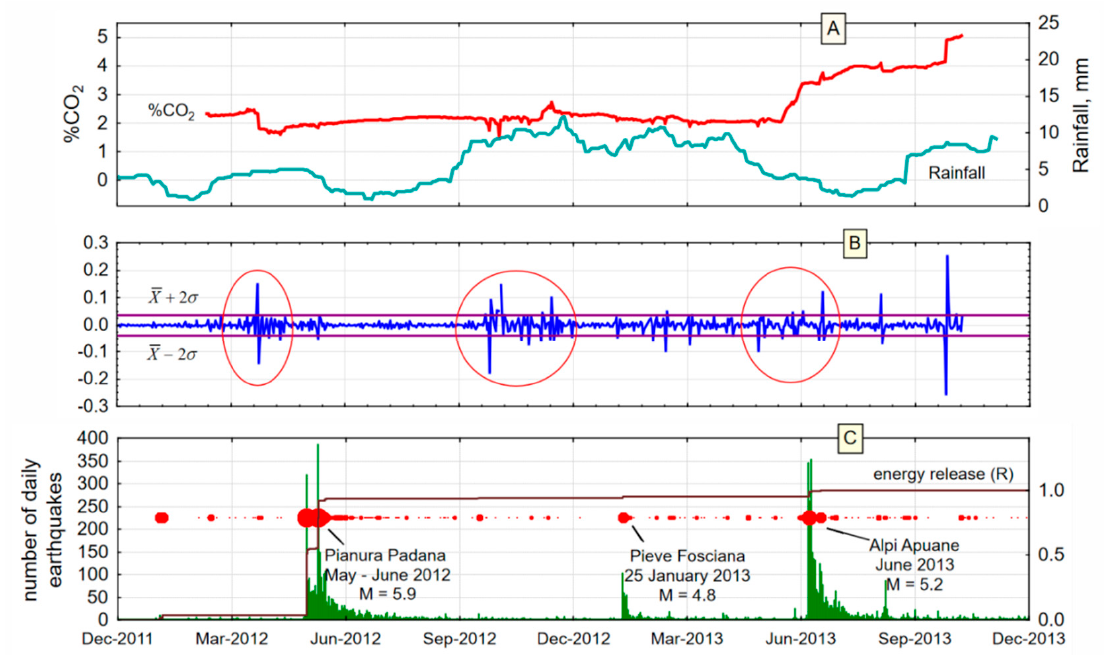
Figure 2. Time series for the Gallicano thermomineral spring (after [29]. ( A ) Aqueous %CO 2 and three-month rain moving average signals (rainfall data from https://www.sir.toscana.it/) during the February 2012 to October 2013 period; ( B ) irregular component of %CO 2 signal (processed with Census I method [32]). Anomalies are encircled by red ellipses; ( C ) seismic activity: green bars-number of daily earthquakes; red dots-seismic events with radius proportional to the magnitude; brown line-normalized cumulative curve of energy release calculated according to the relation logE = 1.5 × M L + 11.8 [33]. Seismic information from the Italian Seismological Instrumental and parametric Database (ISIDe: